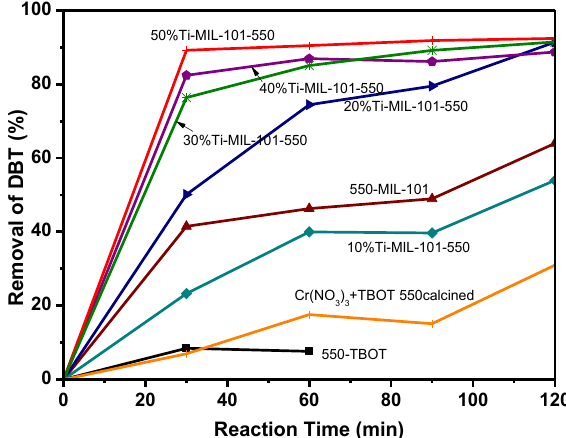
Figure 4. ODS catalytic reactivities of single TiO 2 , single Cr 2 O 3 , and TiO 2 /Cr 2 O 3 composites. Table 3. Catalytic performance comparison of representative Ti-based catalysts in ODS of DBT.